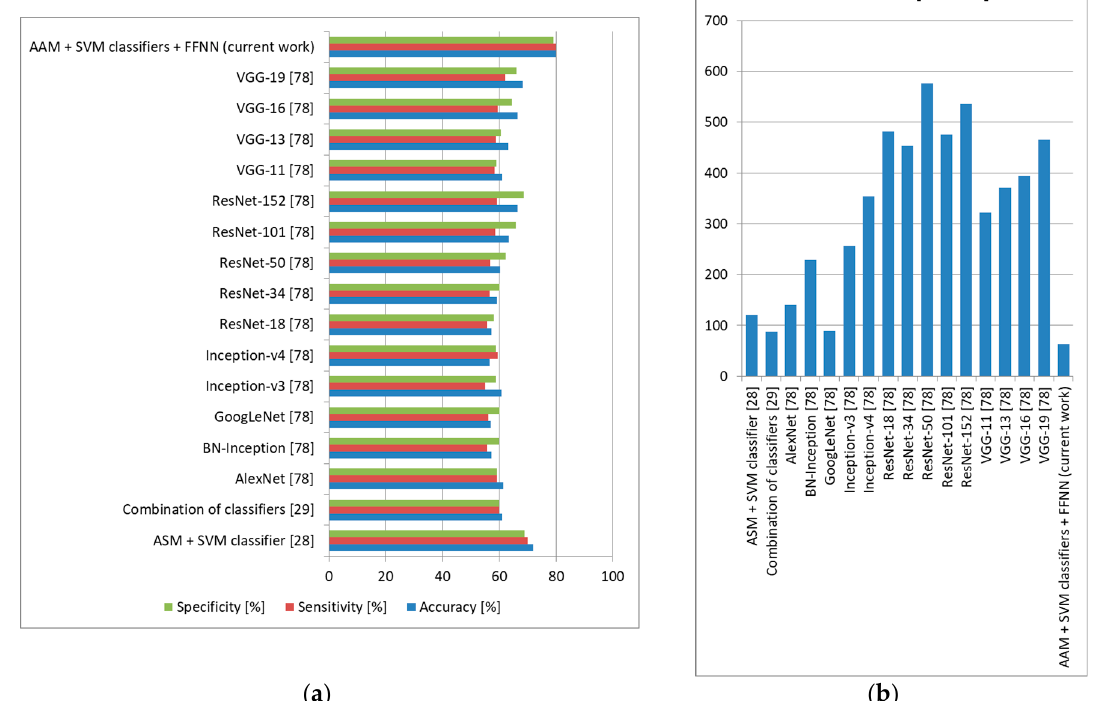
Figure 20. Anxiety prediction comparison to state-of-the-art methods (own database). ( a ) Average accuracy, sensitivity, and specificity, ( b ) Average prediction time (seconds).